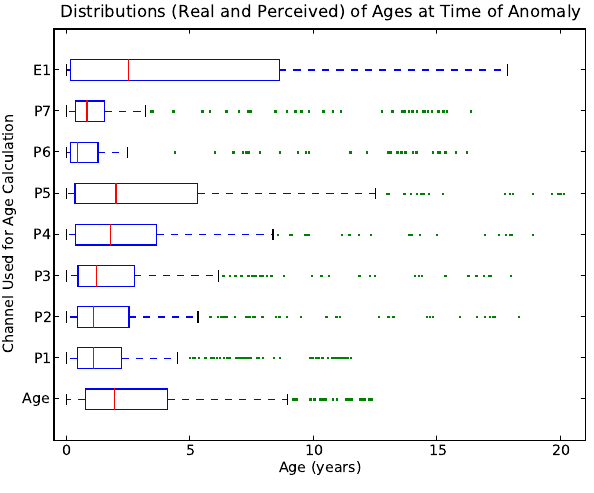
Fig. 2. Box and whisker representation of the distribution of satel- lite actual ages (bottom box) and perceived ages calculated from each energy channel. P1 marks the lowest proton channel listed in Table 1, P7 the highest, and E1 marks the electron